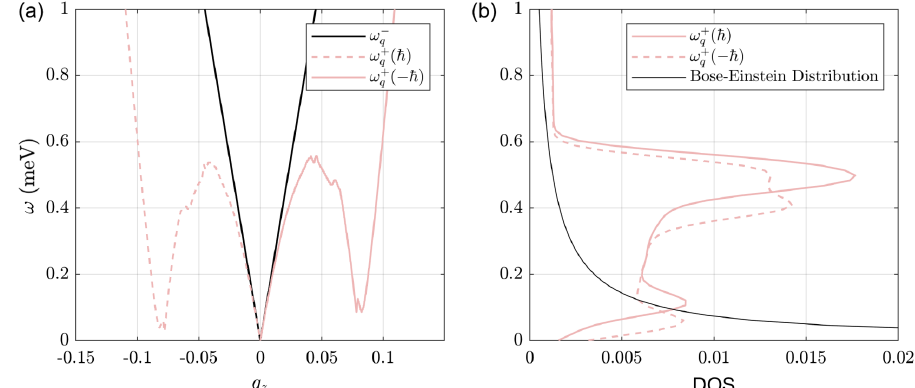
8. (a) Renormalized phonon dispersion of β -Ag 2 Se at temperature T ¼ 15 . 7 K, where the applied magnetic field is B ¼ 5 T and 0 . 2 meV. (b) Corresponding density of states (DOS) of each chiral phonon mode. Solid the rotation symmetry breaking term is δ T ¼ (dashed) red line refers to phonon mode with þ ℏ ( − ℏ ) angular momentum. The black line is the Bose-Einstein distribution at − Þ T ¼ 15 . 7 K. The DOS of unscreened phonon modes ( ω ð q ) are not plotted because their angular momenta are exactly canceled